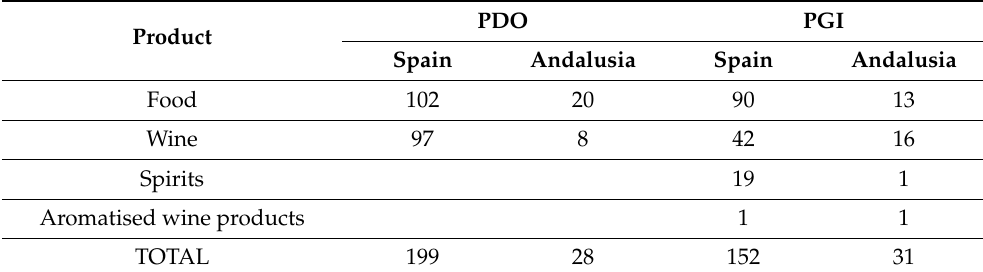
Table 1. PDO and PGI from